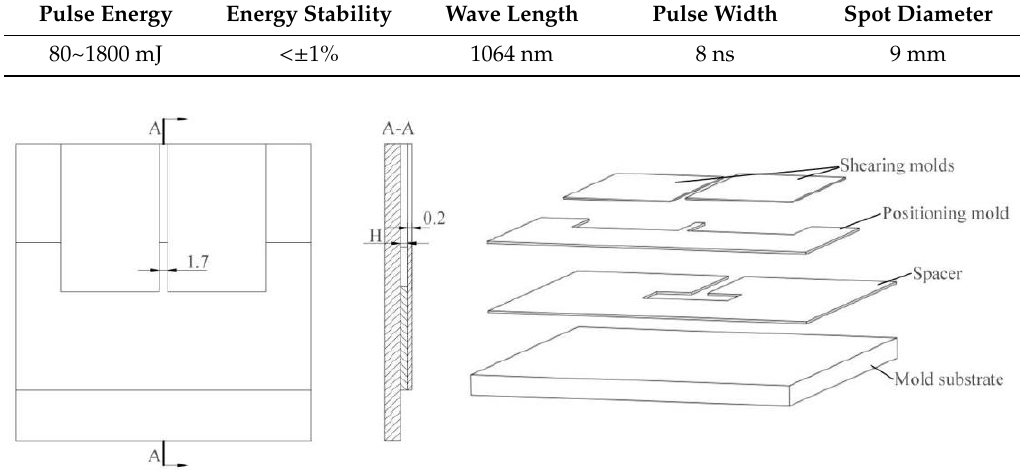
Figure 2. Primary designed and combined rectangular shearing mold.